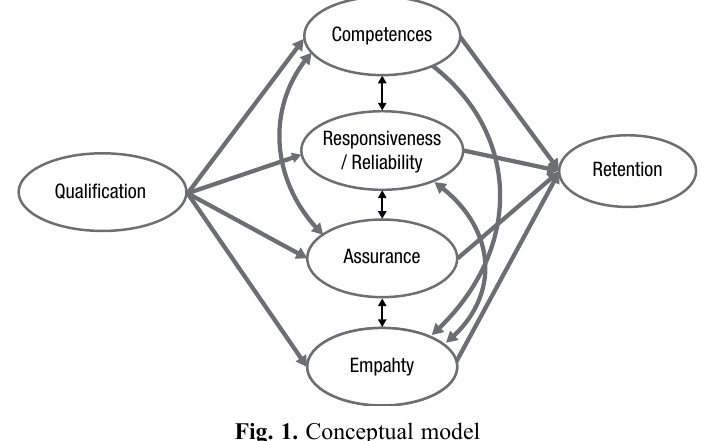
Fig. 1. Conceptual